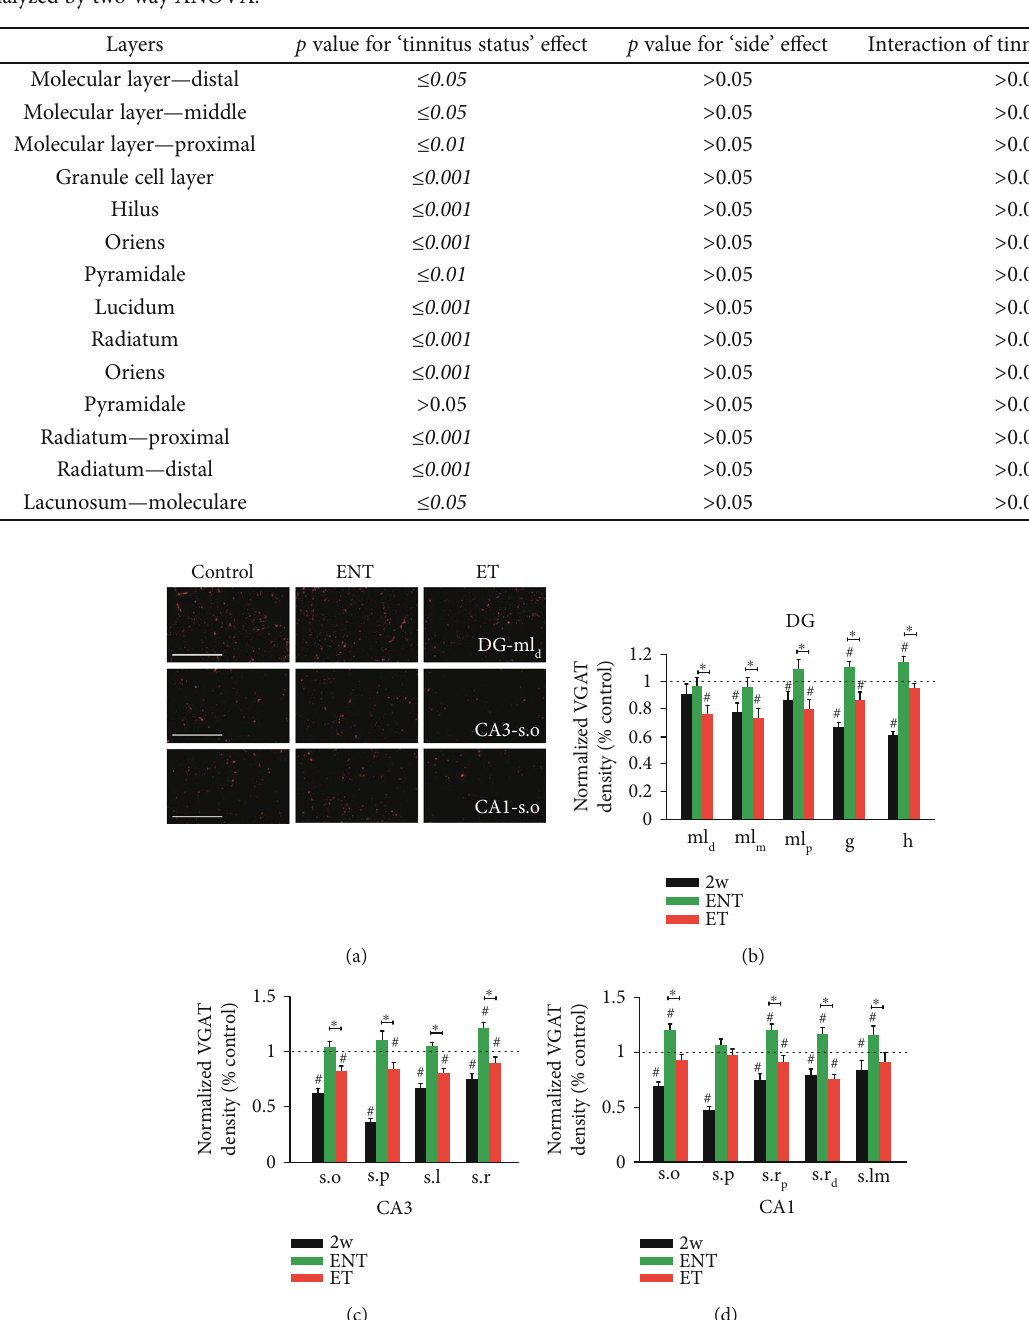
Table 3: Animals with tinnitus and animals without tinnitus exhibited di ff erent VGAT labeling in most layers but no di ff erence between both sides, analyzed by two-way ANOVA.